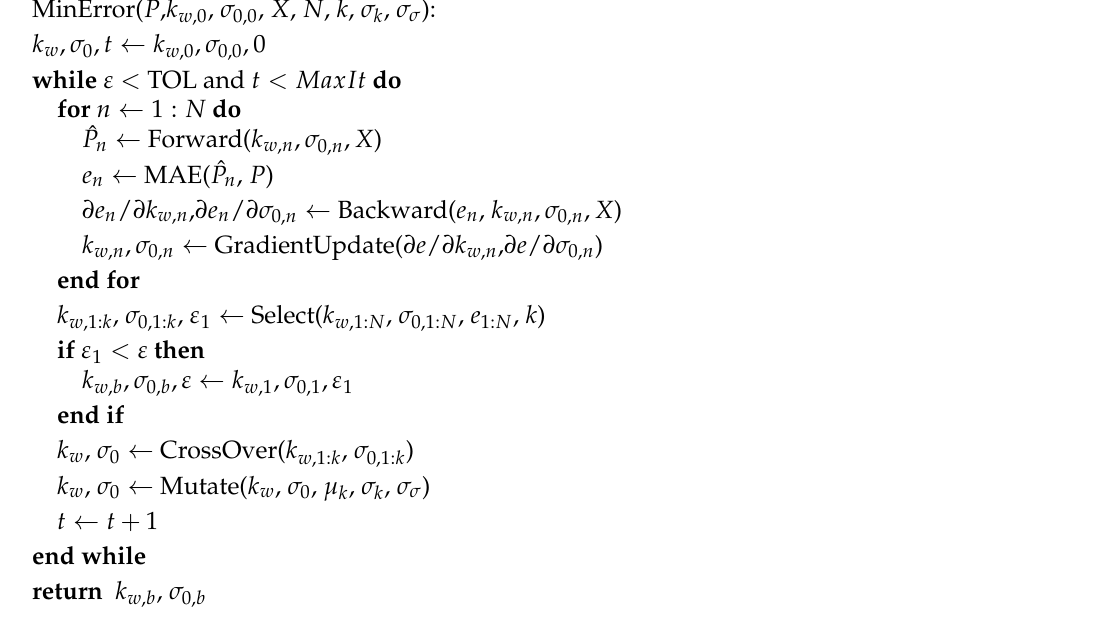
Algorithm 1 Genetic algorithm gradient descent minimization of mean absolute error of lifting line